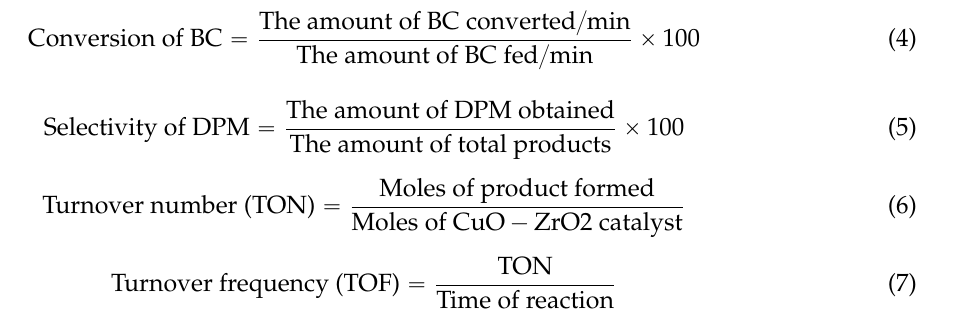
Table S1: Activation energies ( Ea ), TON and TOF for the catalytic reaction conducted over different catalysts, Table S2: Crystal Lattice parameters measured from XRD